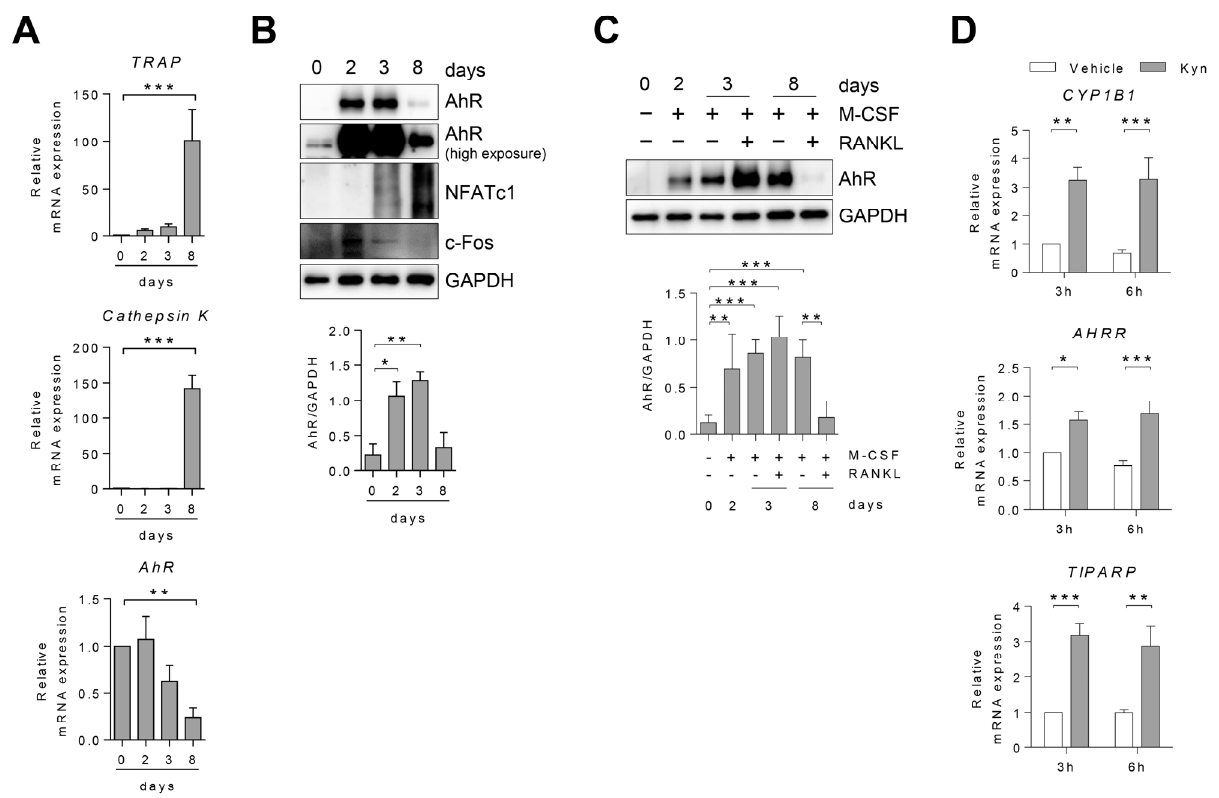
Figure 1. The expression of AhR changes during osteoclastogenesis. Human PBMC CD14+ cells were cultured with M-CSF (20 ng/mL) for 2 days, and then RANKL (40 ng/mL) was added for 6 days. ( A ) AhR , Cathepsin K , and TRAP mRNA expression was measured using RT-qPCR and normalized to that of GAPDH . ( B , C ) Level of AhR protein was detected by immunoblotting and measured by Image J. ( D ) OCPs were treated with Kyn (100 µ M) for 3 h or 6 h. AhR-induced genes of CYP1B1 , AHRR , and TIPARP were analyzed using RT-qPCR and normalized to that of GAPDH. Data are shown as mean ± SD of more than five independent experiments and one-way or two-way ANOVA tests were applied. * p < 0.05, ** p < 0.01, *** p < 0.001.